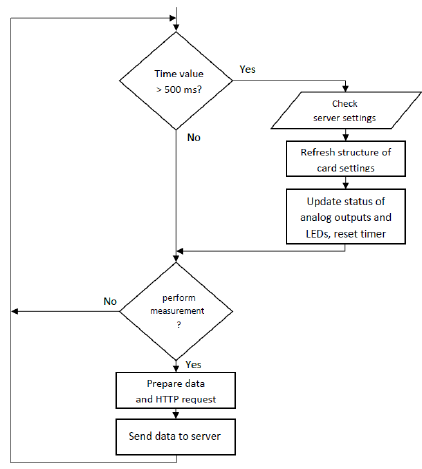
Fig. 2. The main program loop of the measuring card